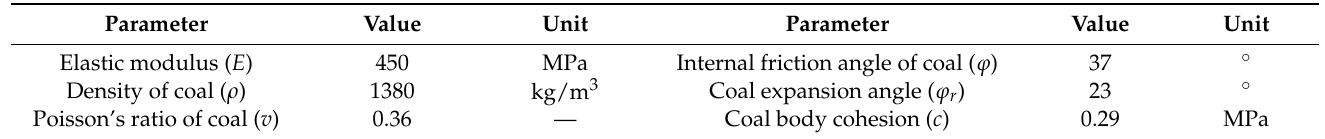
Table 1. Model coal material parameters.